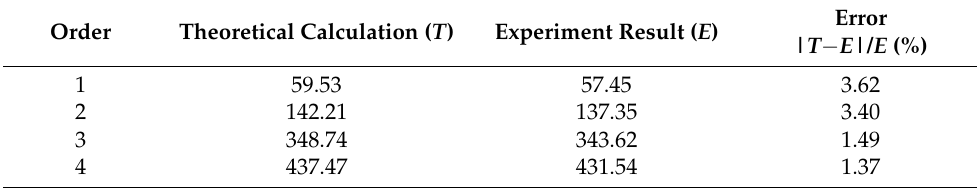
Table 3. The first four order natural frequencies of the sandwich plate obtained by the presented method and experiment (Hz).